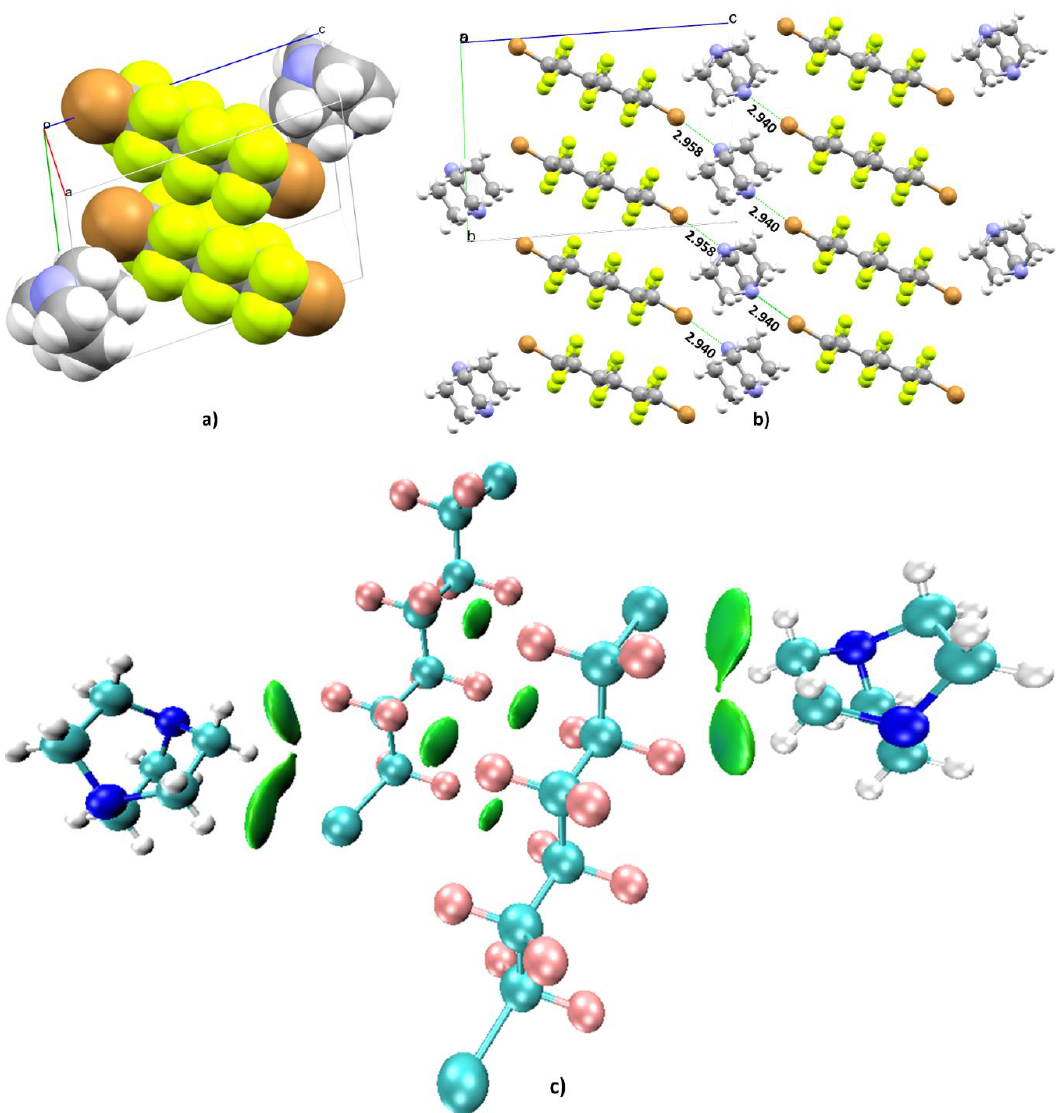
Figure 21. ( a ) The ( a ) space-filling model of the unit cell and ( b ) the ball-and-stick model of the 2 × 2 supercell structure of the crystal of 1,4-diazabicyclo[2.2.2]octane 1,6-dibromo-1,1,2,2,3,3,4,4,5,5,6,6-dodecafluorohexane (CSD ref: CEMGEJ). ( c ) IGM isosurface plot (isovalue = 0.0050 a.u.) for molecular domains in the unit cell, illustrating possible halogen-center intermolecular bonding scenarios. Selected bond distances are shown in Å .